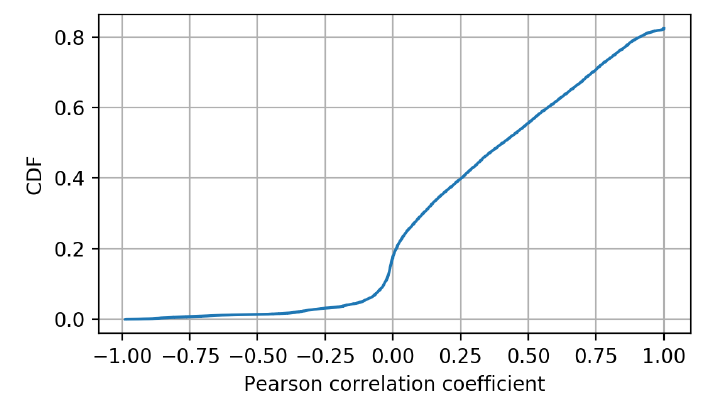
Figure 6. Cumulative Distribution Function of Pearson correlation coefficient obtained for the set of